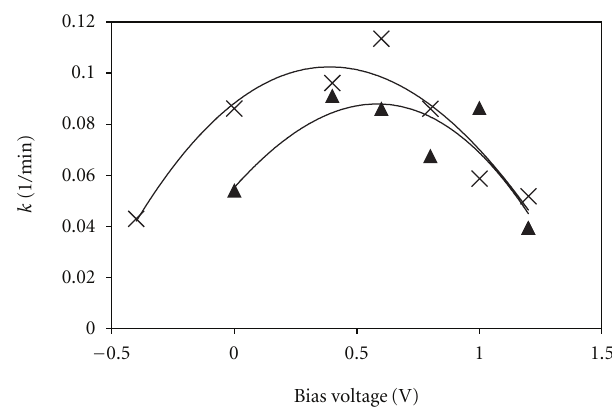
Figure 6: The rate constants measured during the photocatalytic degradation of OCTS as a function of the bias applied to interdigitated electrodes having stripes’ width of 100 µ m (crosses) and 50 µ m (filled